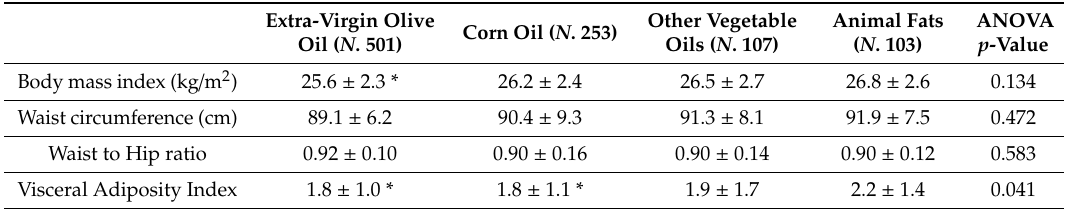
Table 1. Anthropometric characteristics of subjects consuming di ff erent predominant cooking fats in everyday meals.